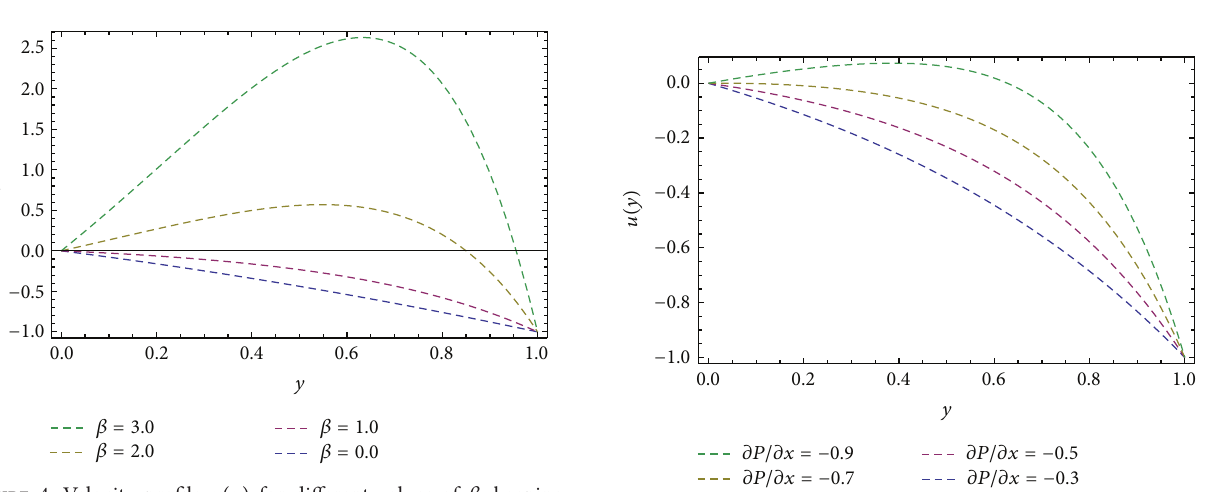
Figure 6: Velocity profile 𝑢(𝑦) for different values of 𝜕𝑃/𝜕𝑥 , keeping 𝛼 = 1.0 , 𝛽 = 1.0 , and 𝜙 = 45 ∘ .